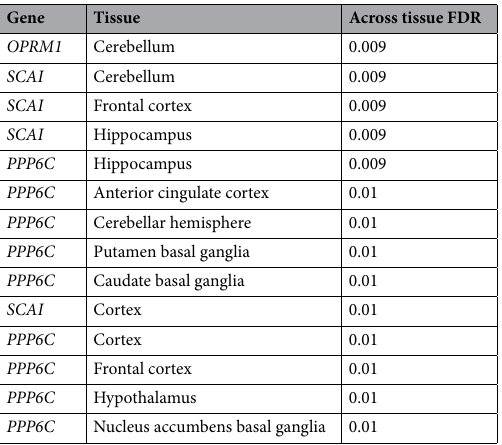
Table 1. Fourteen gene-brain region combinations exhibiting predicted genetically driven differential gene expression in human brain regions associated with OA (across tissue FDR < 0.05) in analysis of gSEM GWAS summary statistics with S-PrediXcan analysis using GTEx version 8 eQTL gene models.